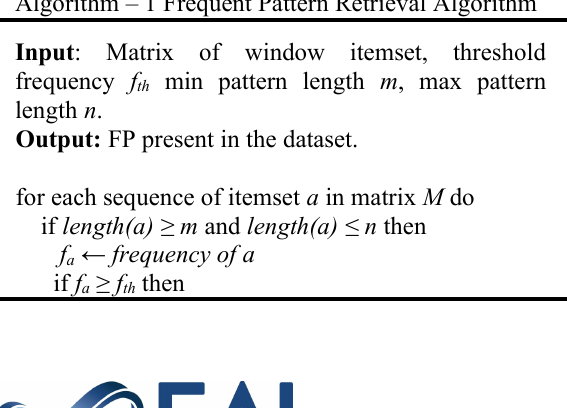
Algorithm – 1 Frequent Pattern Retrieval